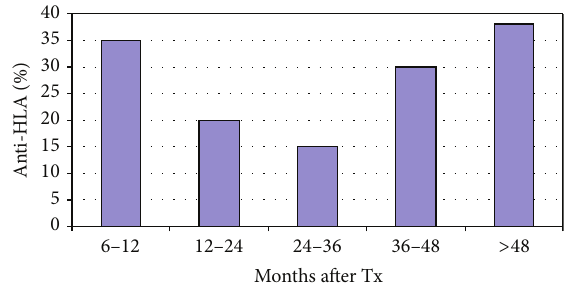
Figure 1: Correlation between presence of anti-HLA antibodies and time after liver transplantation.